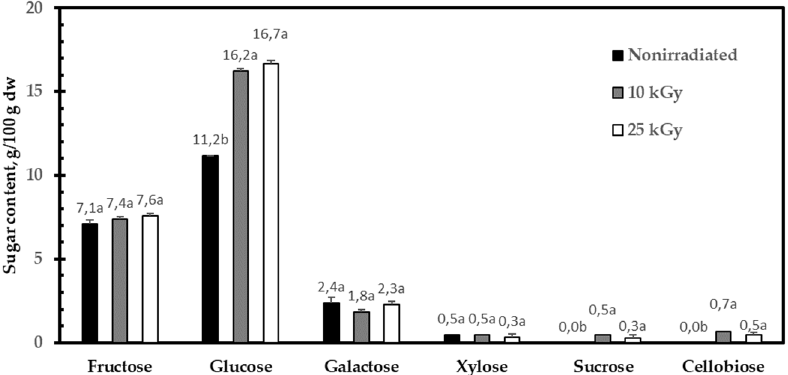
Figure 1. Sugar composition of non-irradiated, 10 kGy-, and 25 kGy-irradiated RH fruits. Different letters denote statistically different values, p < 0.05; dw—dry